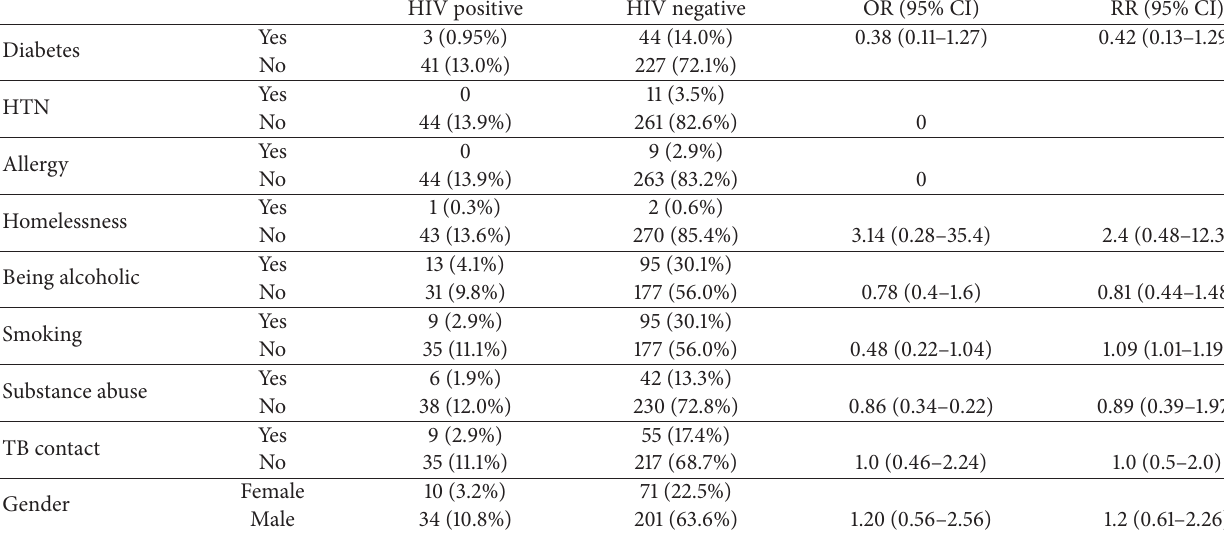
Table 6: Risk factors associated with TB patients with HIV positive and